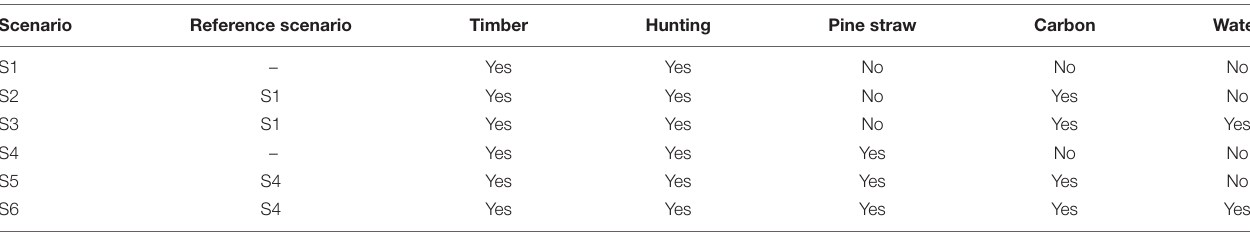
TABLE 1 | Scenarios selected for the analysis in the